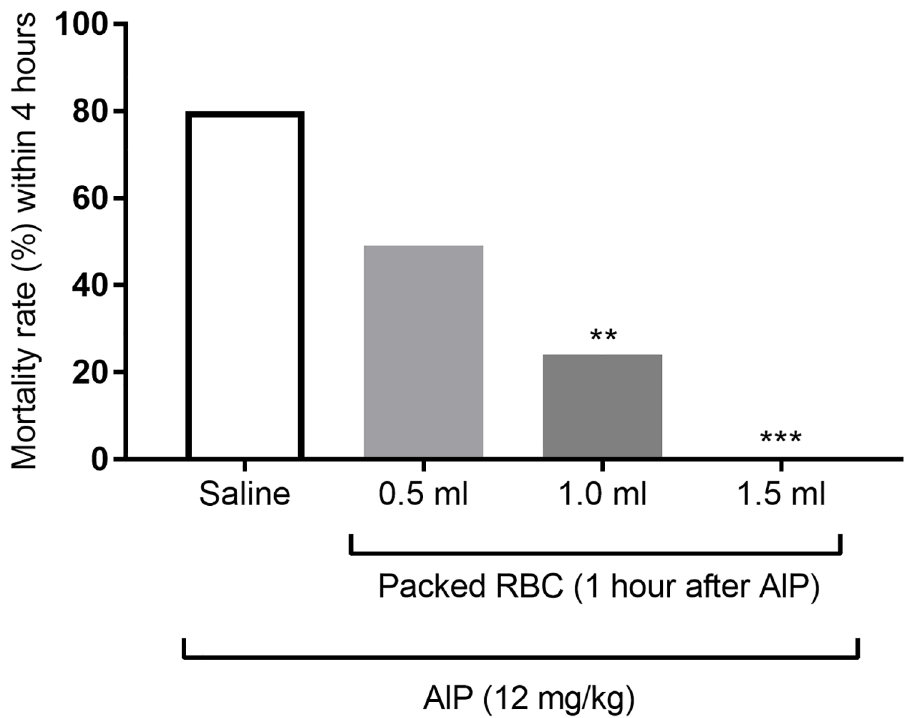
Fig 3. Effects of transfusions of different volumes of fresh packed red blood cells (RBC) on mortality rate of aluminum phosphide (AlP)-poisoned rats. Packed RBC suspensions (0.5, 1 and 1.5 ml) were infused 60 min after oral administration of AlP (12 mg/kg) and the mortality rate was assessed within 4 hours. (cid:3) P < 0.05, (cid:3)(cid:3) P < 0.01, (cid:3)(cid:3)(cid:3) P < 0.001 compared to saline-treated group.